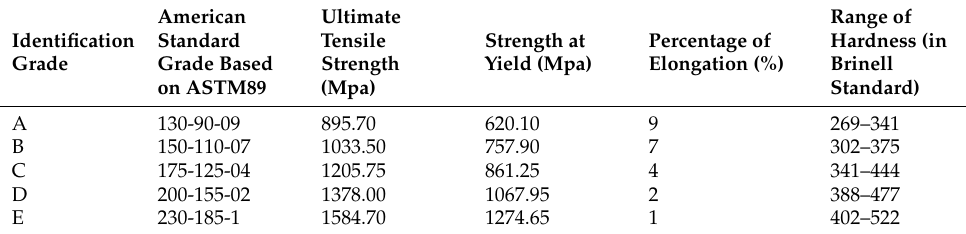
Table 2. Different grades of austempered ductile iron and the corresponding mechanical